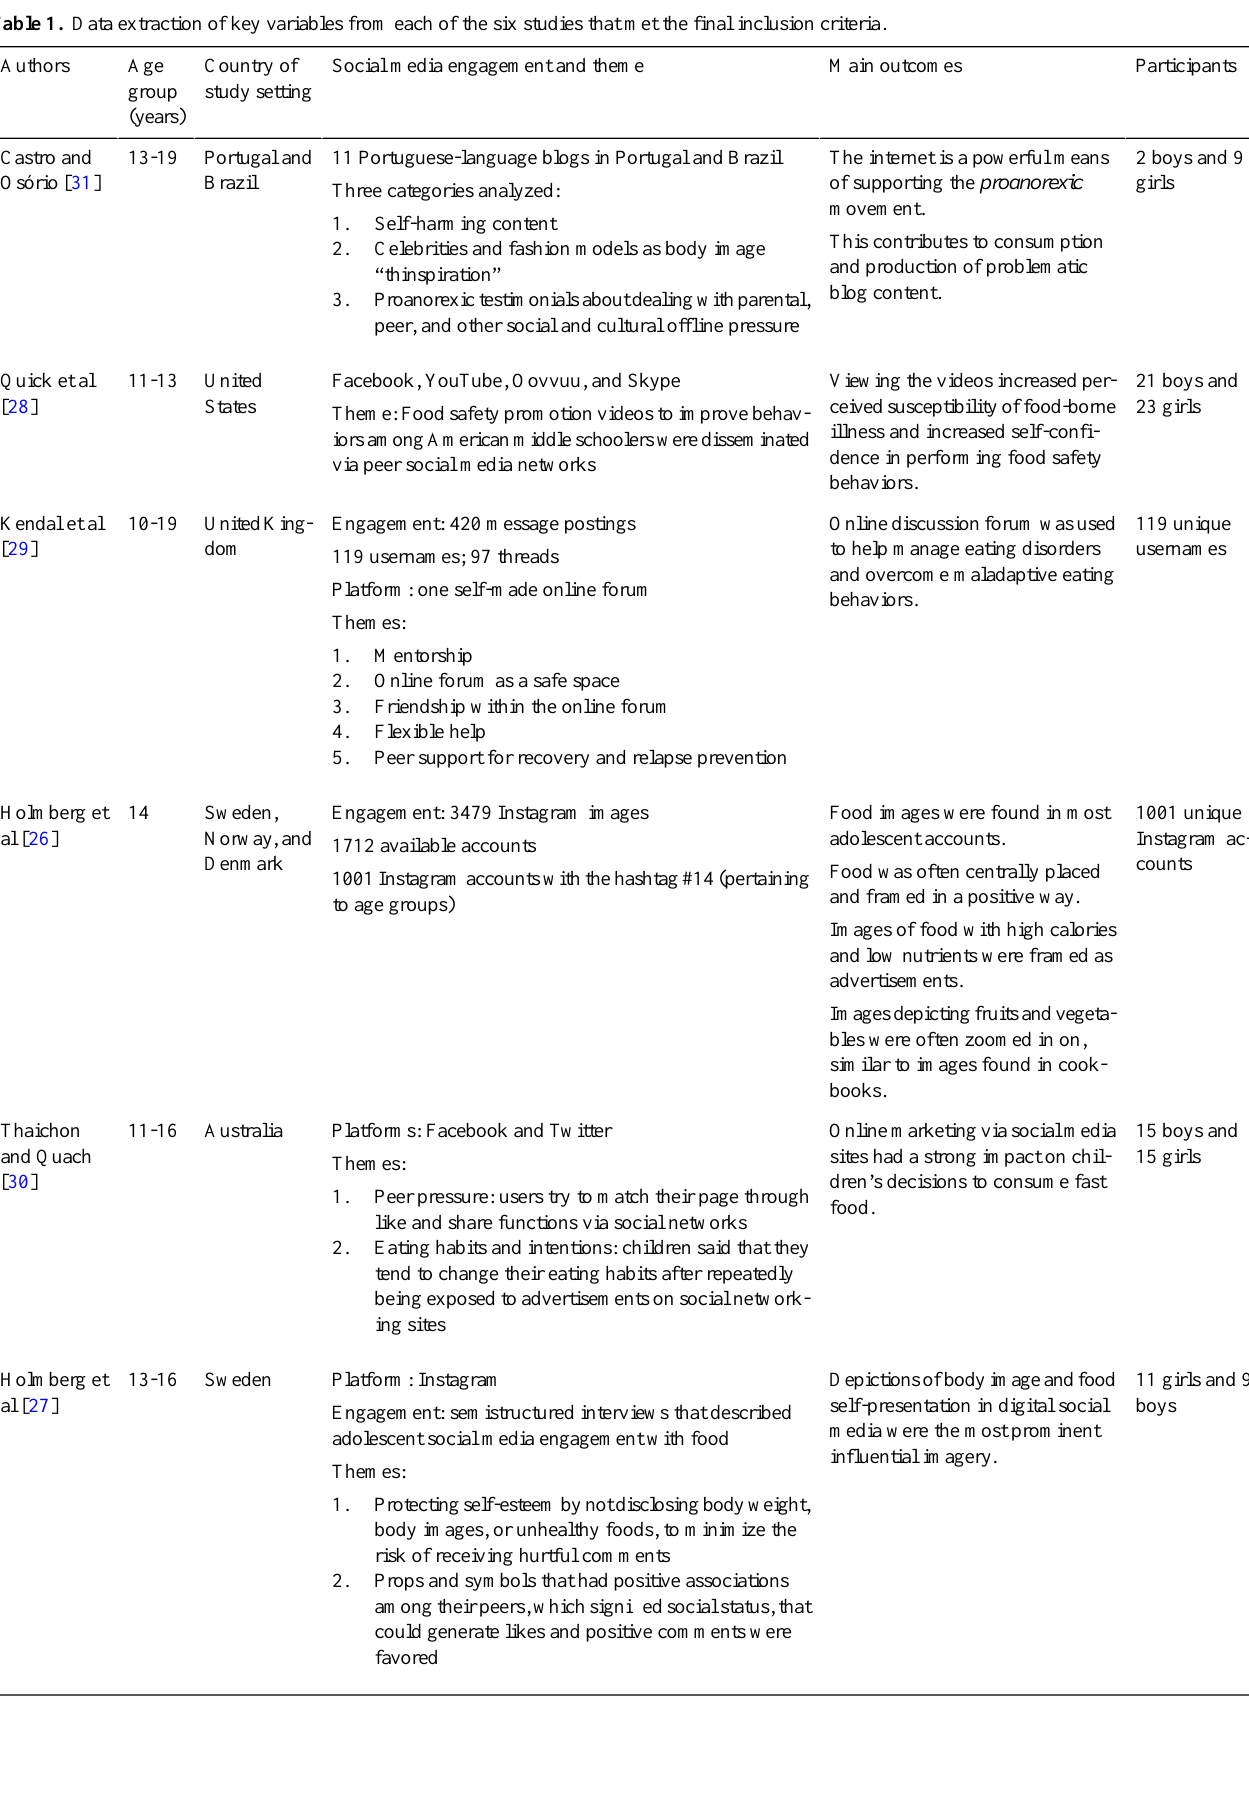
Table 1. Data extraction of key variables from each of the six studies that met the final inclusion criteria.